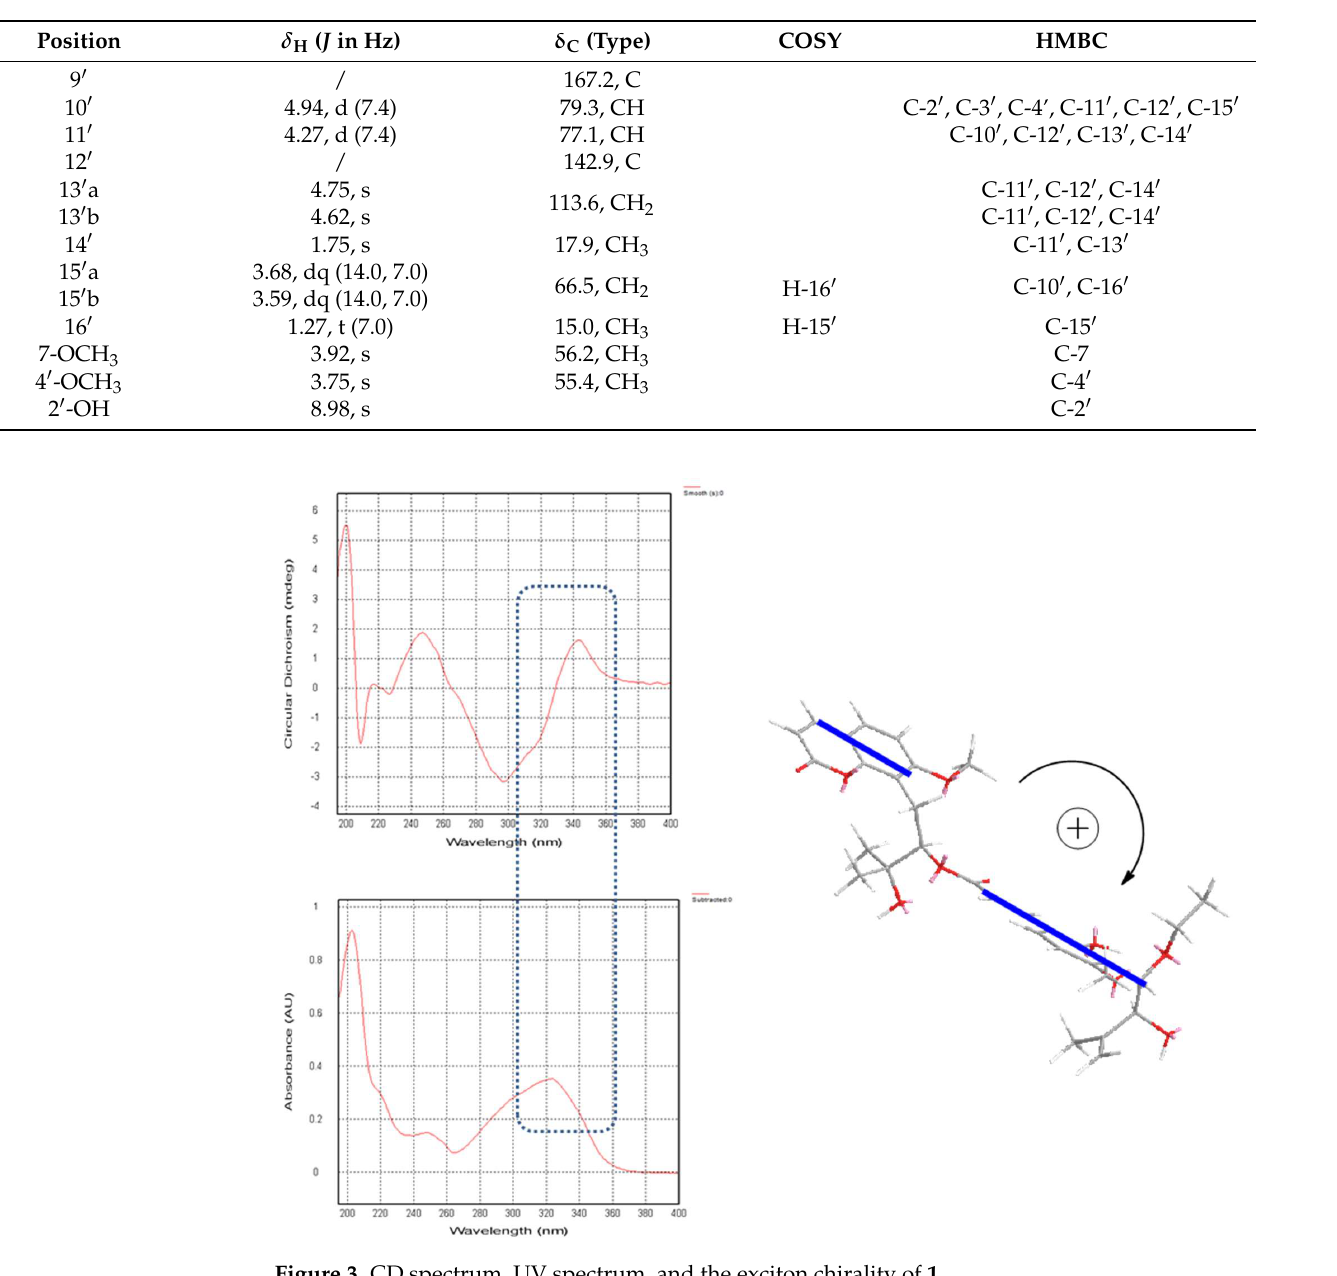
Figure 3. CD spectrum, UV spectrum, and the exciton chirality of 1.